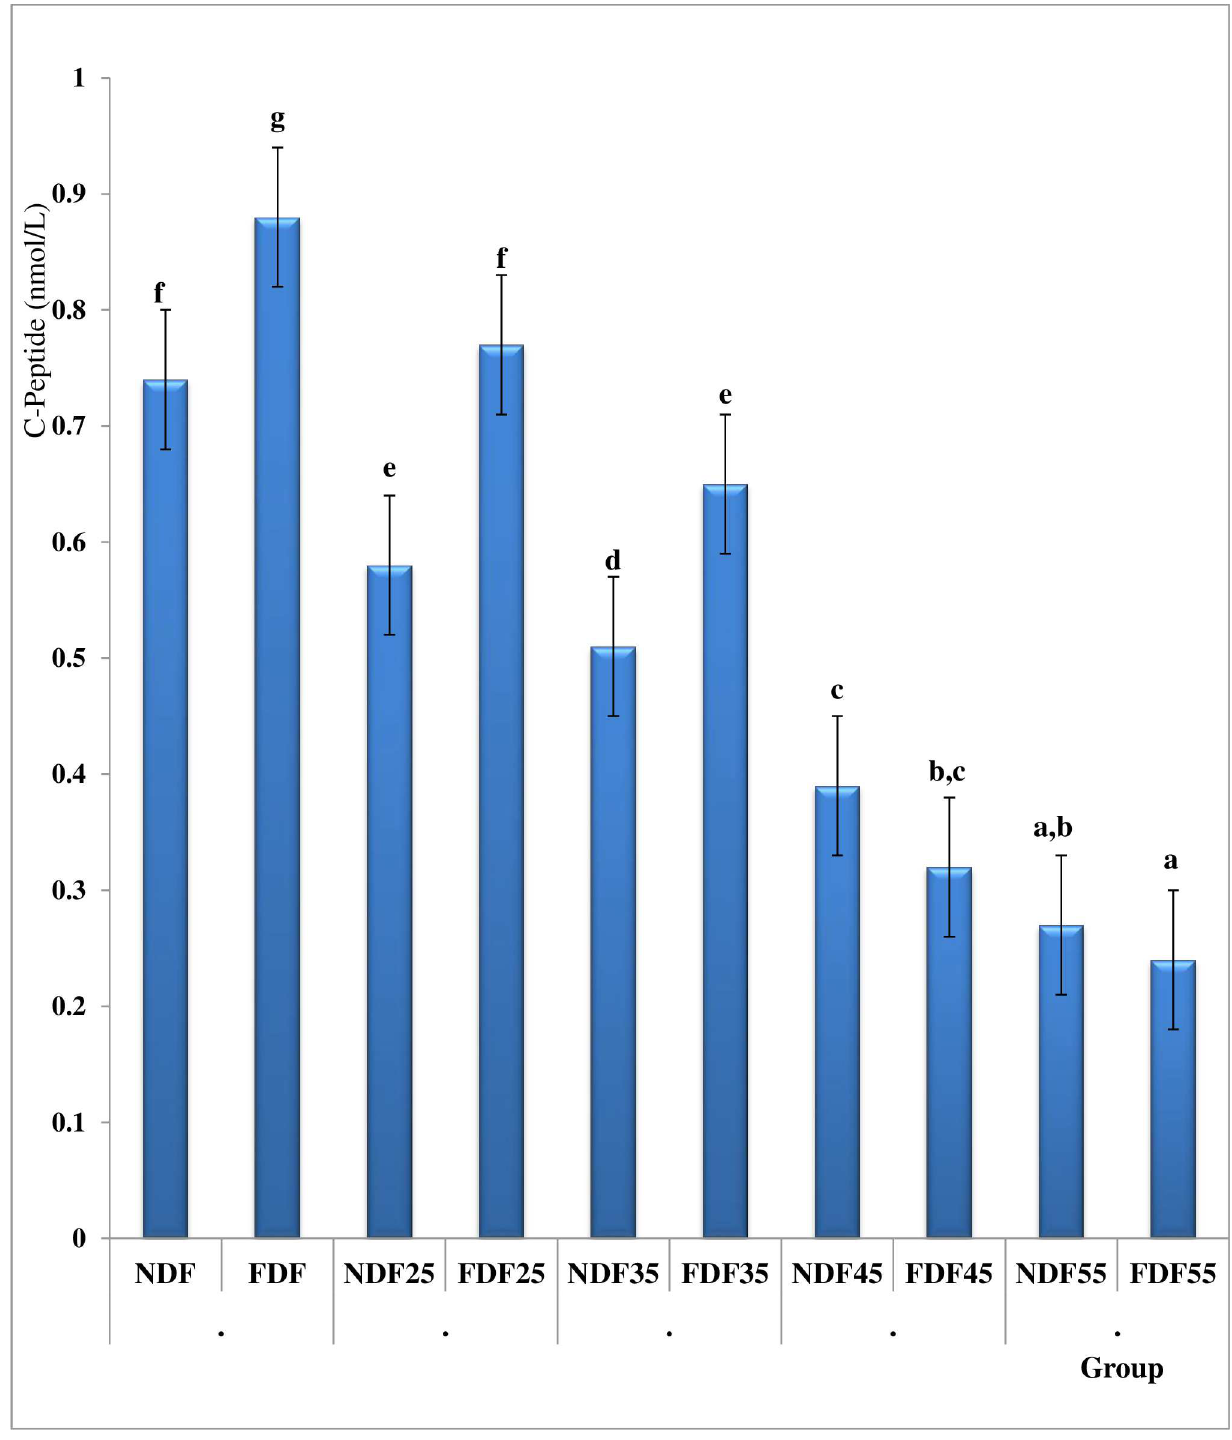
Fig 3. Fasting Serum C-Peptide Levels in Different Animal Groups. Data are presentedas mean ± SD of 6–8 animals per group. Bars with different superscript indicate significantdifference (P < 0.05). Normal serum C-Peptide is 0.17–0.90nmol/L. NDF: Group fed with Normal Diet Feed + water and treated with normal salineas control NDF 25 : Group fed with Normal Diet Feed + Water and treated with 25mg/kg bw, STZ. NDF 35 : Group fed with Normal Diet Feed + Water and treated with 35mg/kg bw, STZ. NDF 45 : Group fed with Normal Diet Feed + Water and treated with 45mg/kg bw, STZ NDF 55 : Group fed with Normal Diet Feed + Water and treated with 55mg/kg bw, STZ. FDF: Group fed with Fortified Diet Feed + 20% fructose and treated with Normal saline FDF 25 : Group fed with Fortified Diet Feed + 20% fructose and treated